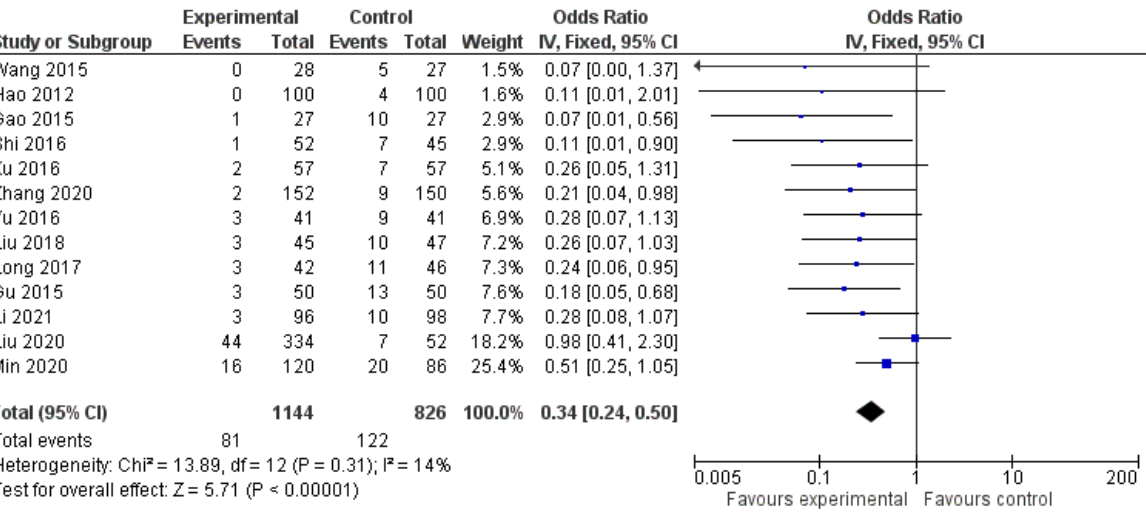
Figure 5. Funnel plot of the studies included in the analysis of the total number of harvested lymph nodes.